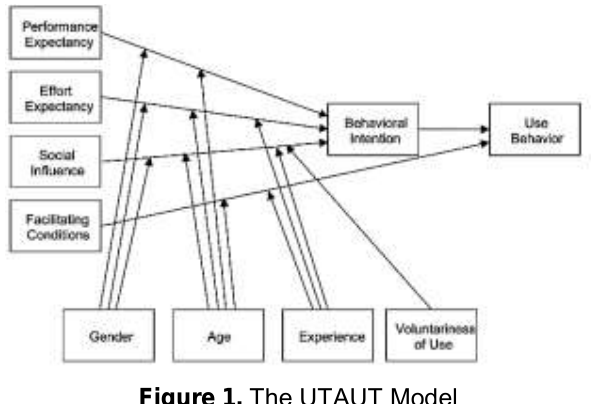
Figure 1. The UTAUT